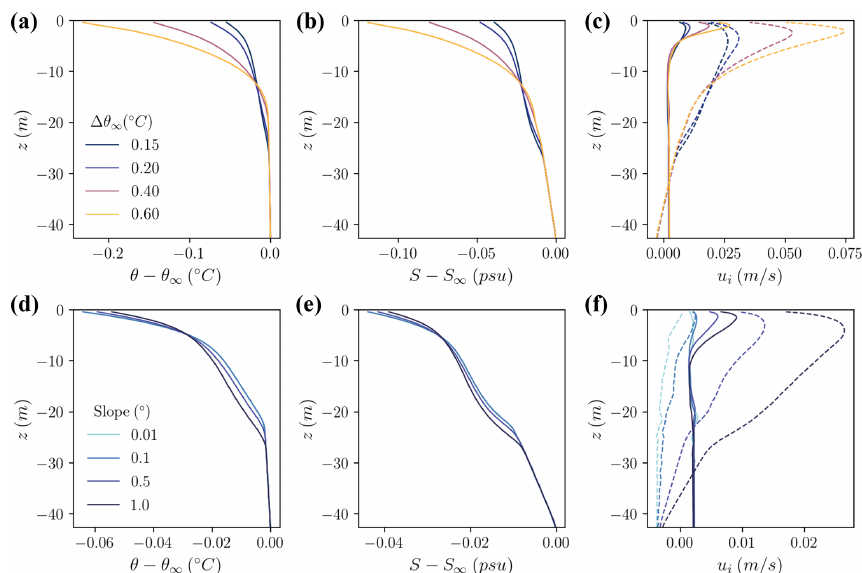
Figure 3. Depth profiles of simulated properties as they vary with (a–c) thermal driving and (d–f) slope, averaged over the last inertial period. (a, d) The temperature relative to far-field temperature, (b, e) salinity relative to far-field salinity, and (c, f) velocity in the y direction (solid line, positive north, cross-slope) and in the x direction (dashed line, positive east, up-slope).